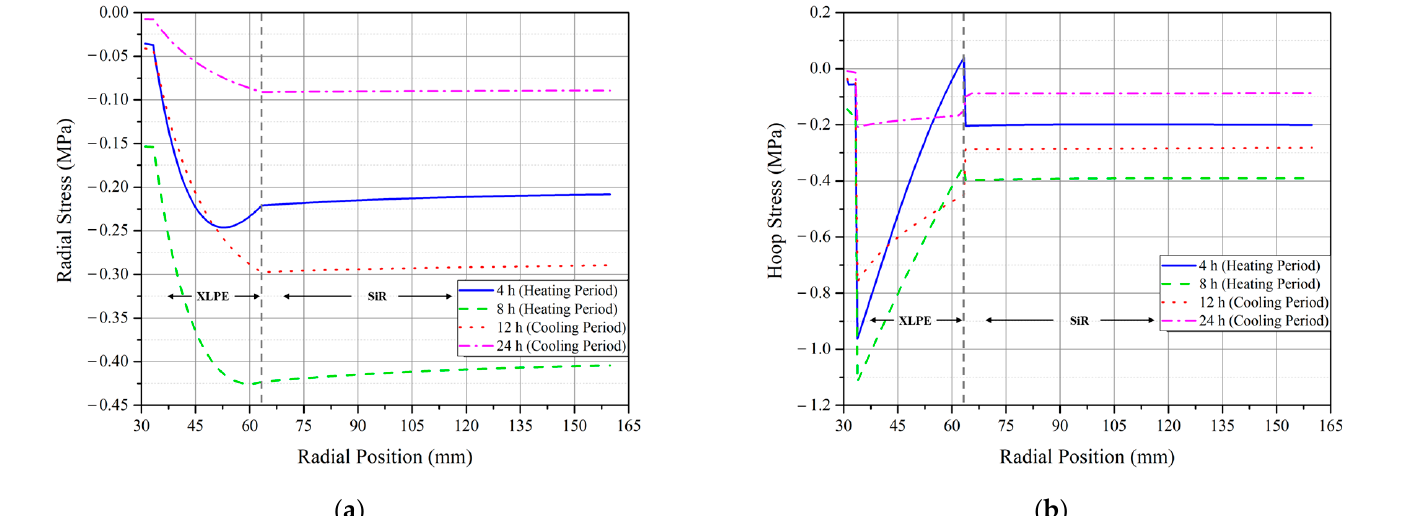
Figure 10. Mechanical stress distribution during load cycle: ( a ) Radial stress; ( b ) Hoop stress.